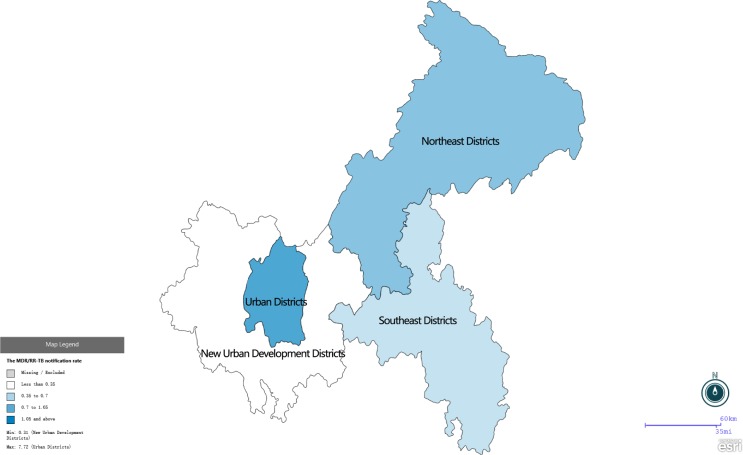
The MDR/RR-TB notification rate of different regions in 2017.